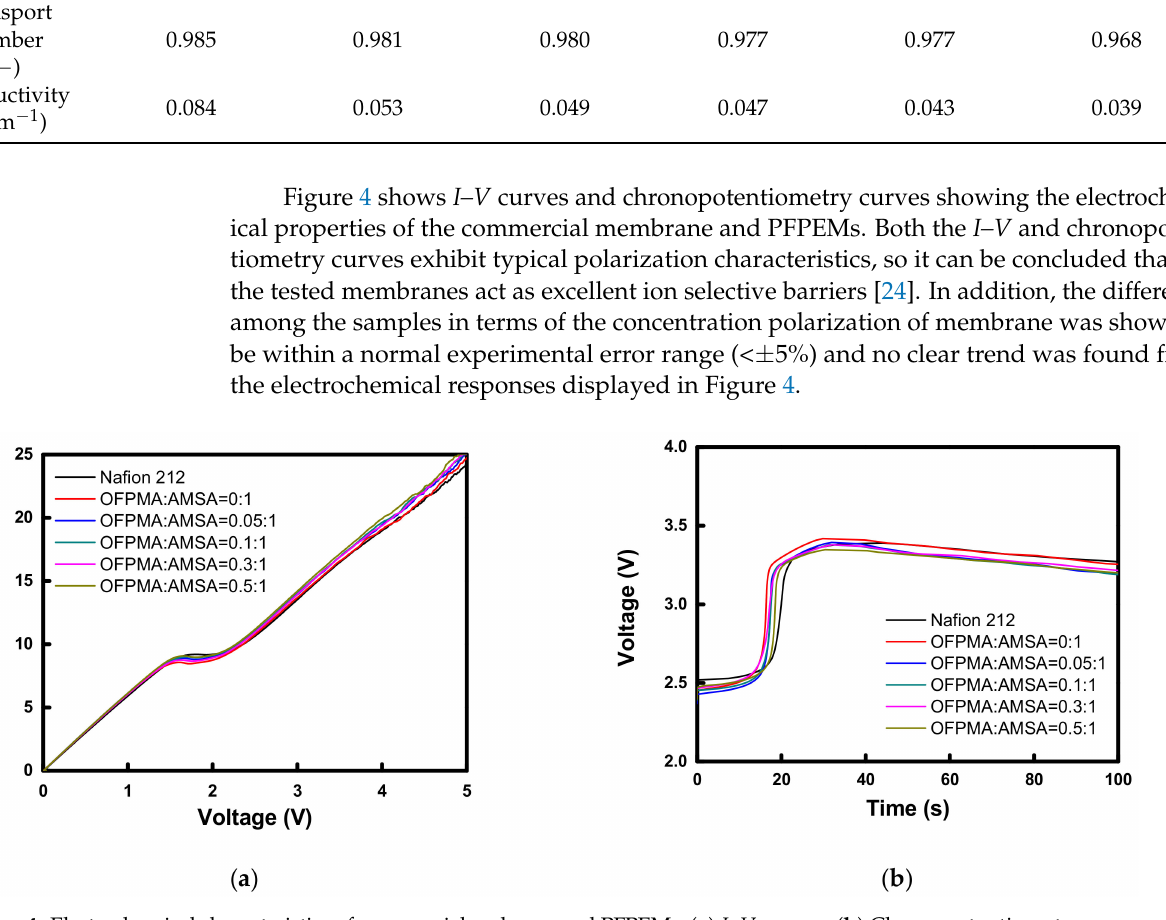
Figure 4. Electrochemical characteristics of commercial and prepared PFPEMs: ( a ) I – V curves; ( b ) Chronopotentiometry